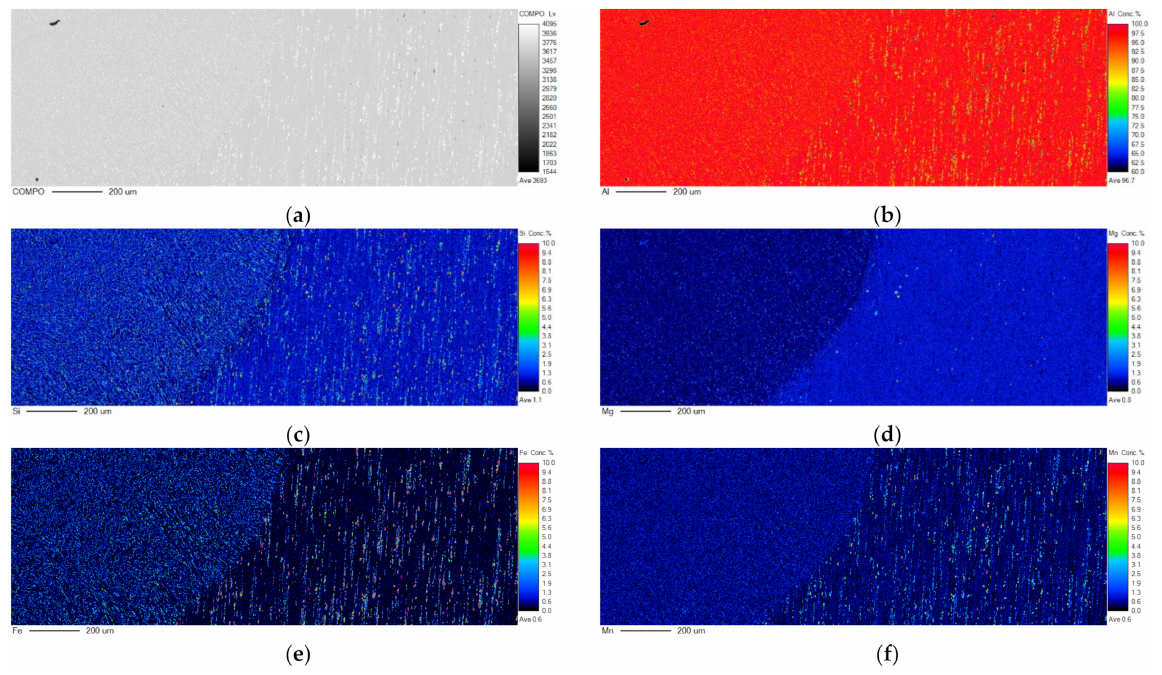
Figure A3. ( a ) BSE image and elemental distribution mappings: ( b ) Al, ( c ) Si, ( d ) Mg, ( e ) Fe, ( f ) Mn.